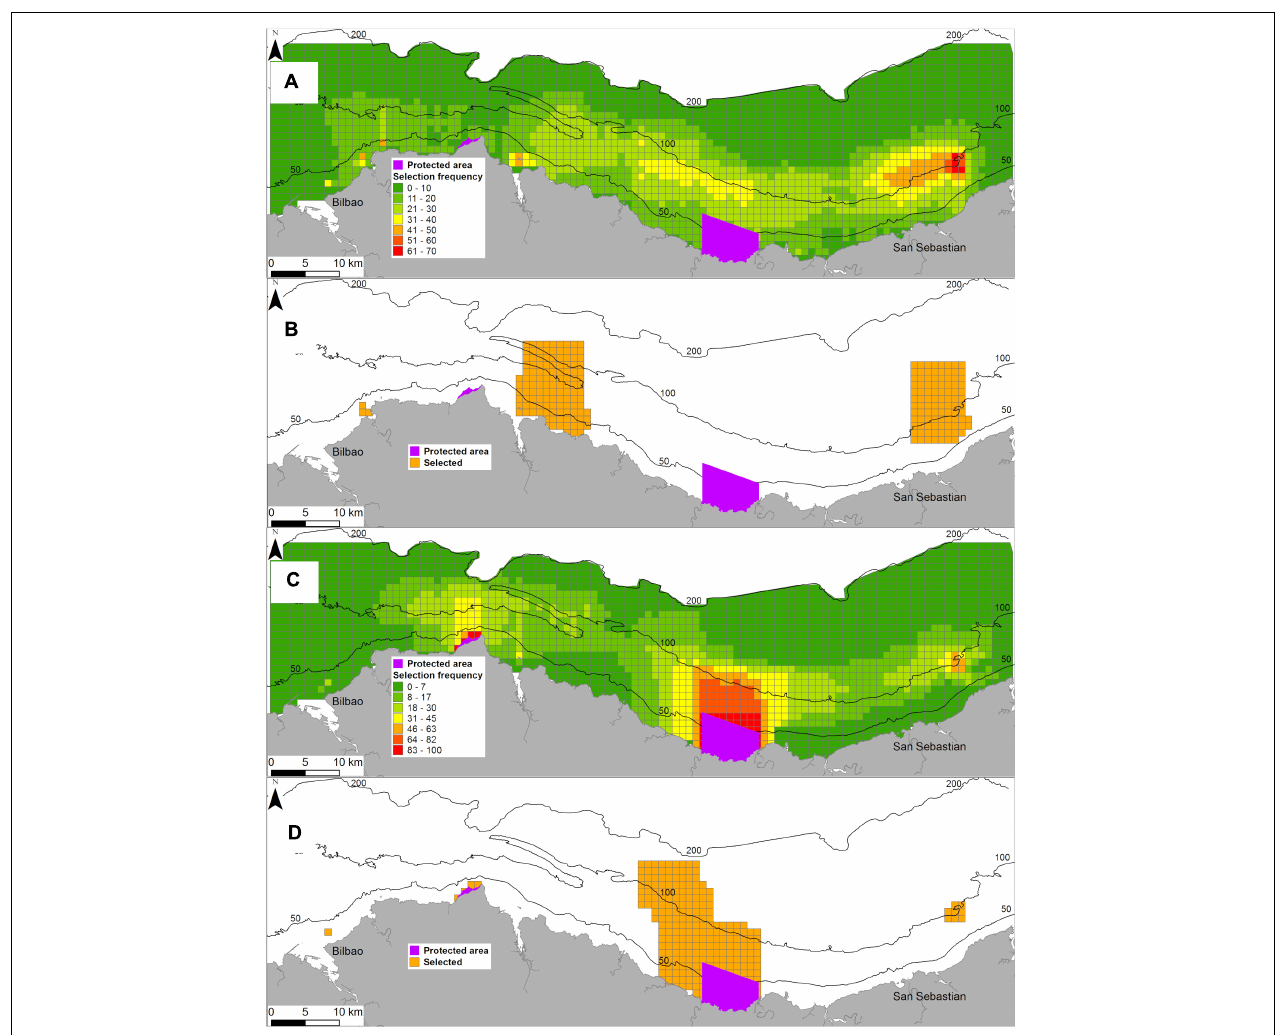
FIGURE 2 | Frequency of selection of Planning Units (PUs) (A) and best solution (B) when the target is to conserve 10% of priority habitat types, very high biological value for ecosystem components, most sensitive benthic habitats to human activities, and the areas with the highest potential of delivering provisioning, regulating and cultural ecosystem services (Scenario 8; see section “Runs and calibration”). Frequency of selection of PUs (C) and best solution (D) for the same conservation targets but when the analysis is run considering the existing Marine Protected